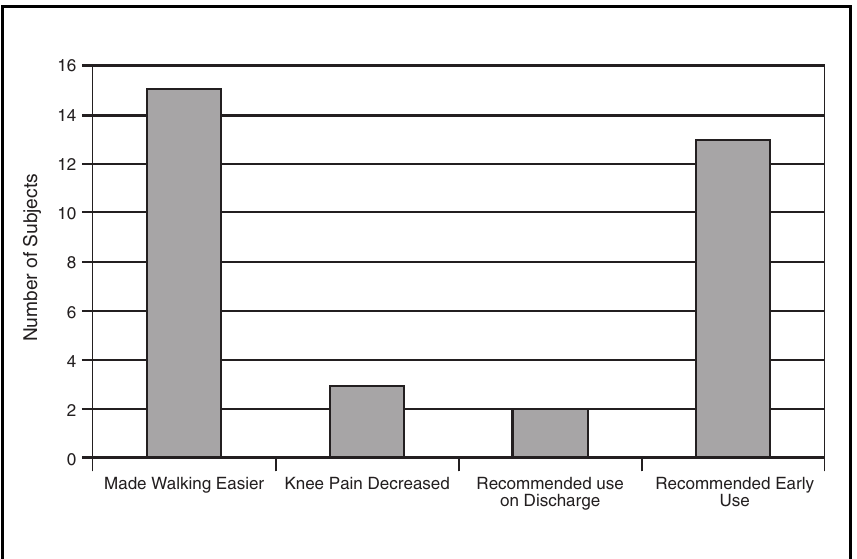
Figure 1: Subjects’ Perceptions of the